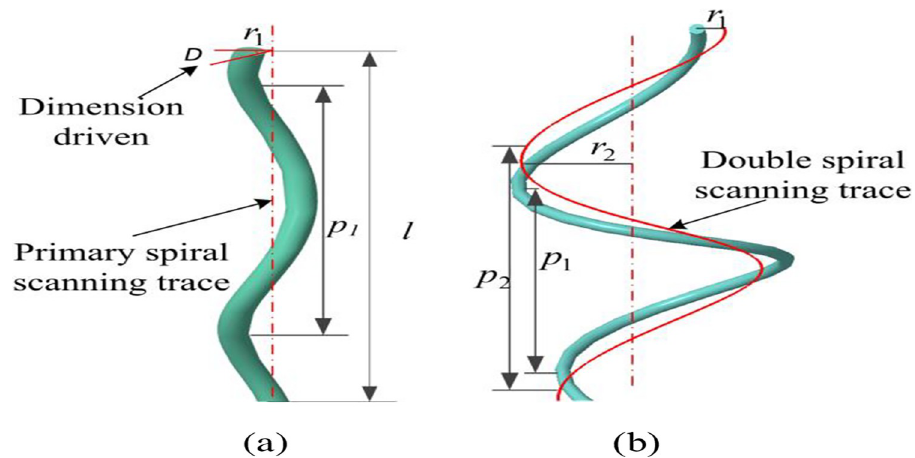
Fig 4. Schematic diagram of spiral structure: (a) primary spiral; (b) double spiral.